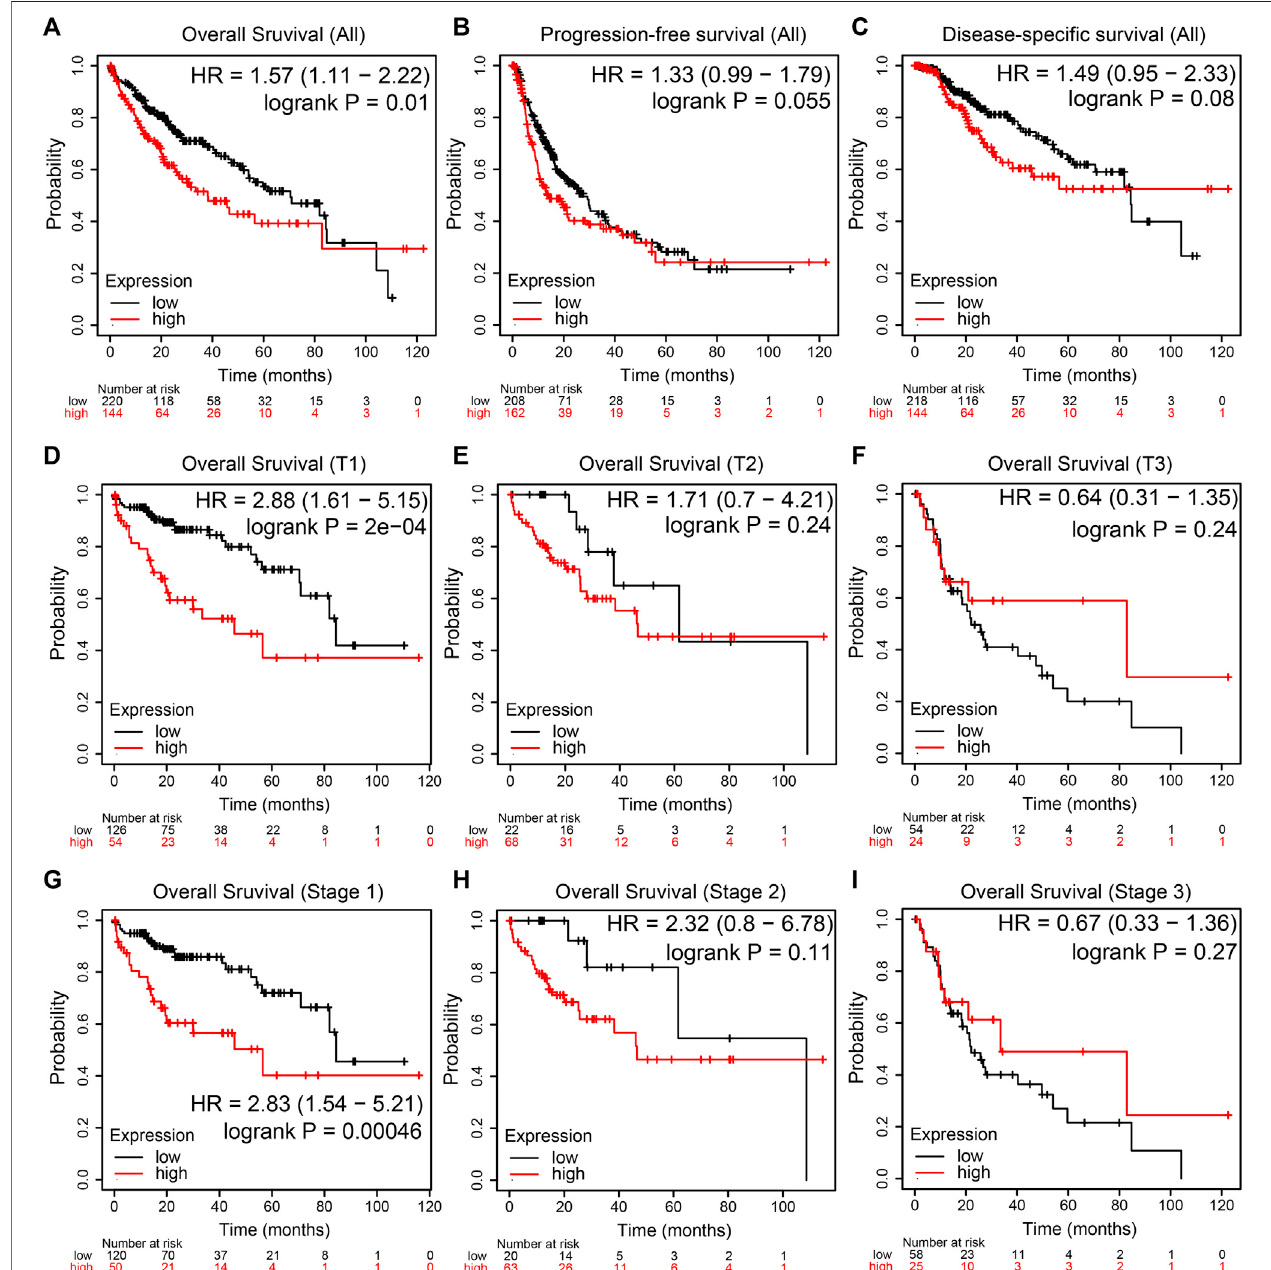
FIGURE6| TheprognosticvalueofNEU1inpatientswithHCC(TCGAcohort) (A – I) TheKaplan-MeiersurvivalcurvescomparingHCCpatientswithlow(black)and high (red)NEU1expression wereplotted (A,D,G) HighexpressionlevelofNEU1wassigni fi cantlycorrelatedwithshorterOSinallHCC, T1,and stage1patients ( p -value < 0.05) (B – C) TheexpressionofNEU1wasnotrelatedtoPFSandDSSinallHCCpatients( p -value > 0.05) (E – F,H – I) NEU1expressionshowednocorrelationwithOSin other T stages and pathologic